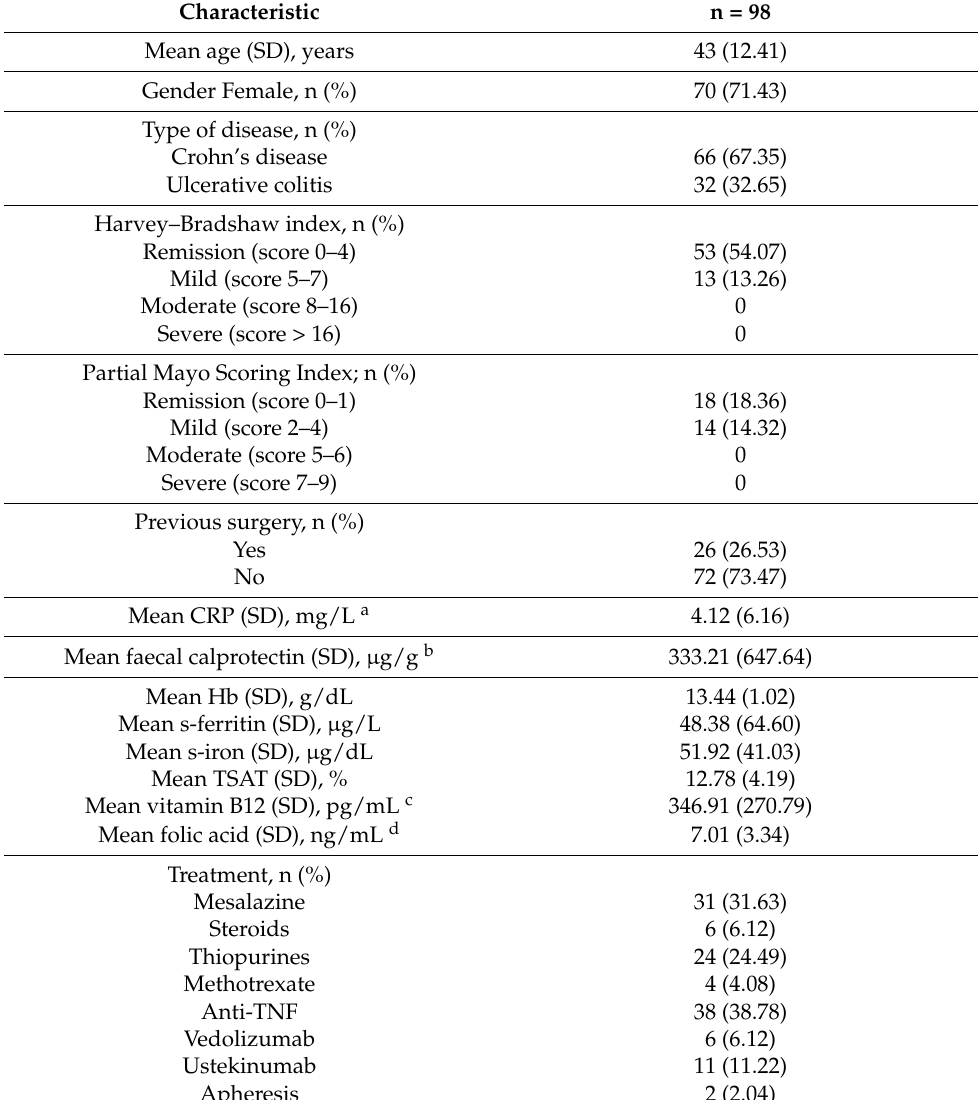
Table 1. Patient baseline